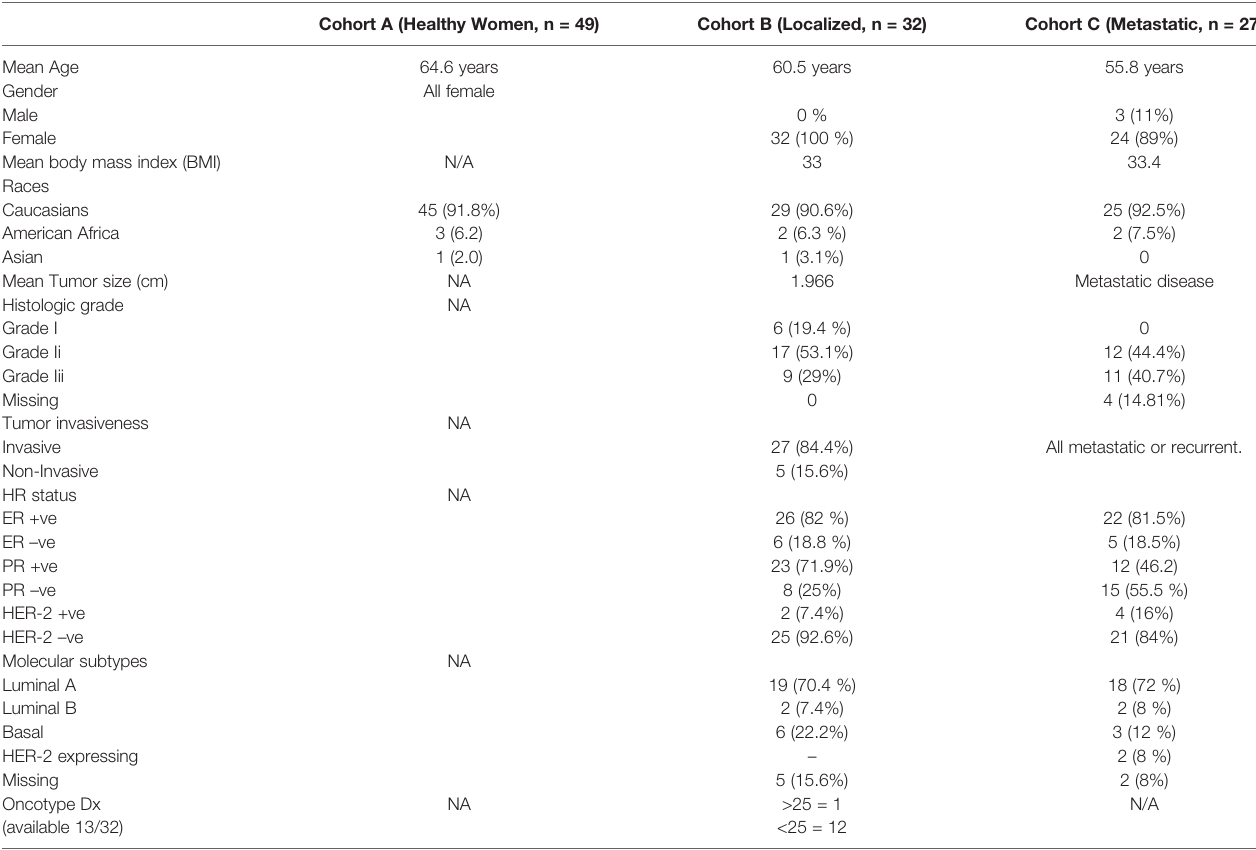
TABLE 1 | Patient